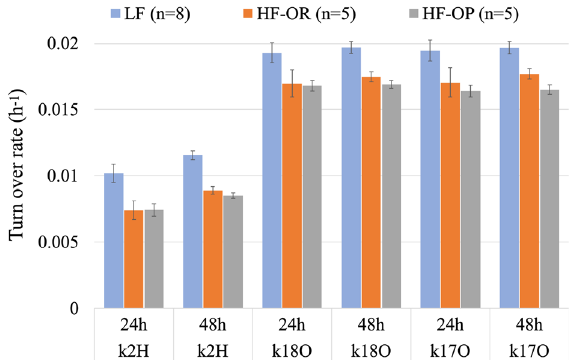
Figure 3. The average turnover rates (h −1 ) of 2 H (k 2H ), 18 O (k 18O ) and 17 O(k 17O ) for the LF (blue, n = 8), HF-OR (red, n = 5), and HF-OP (grey, n = 5) mice groups based on the final samples taken at 24 h or 48 h after taking the initials. The error bar is ± SE.